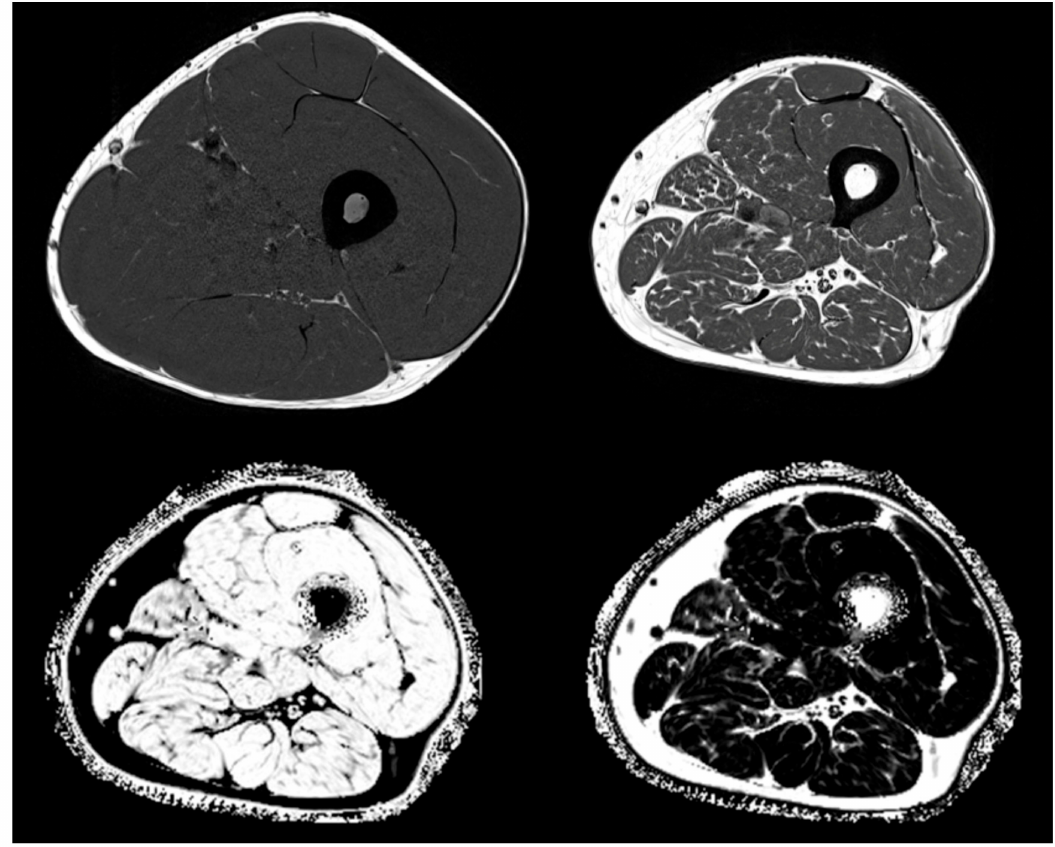
Figure 3. Magnetic resonance imaging (MRI)-based muscle imaging. Weighted image of young healthy (top left) and elderly sarcopenic male (top right). Water fraction (bottom left) and fat fraction (bottom right) images of subject shown in top right.